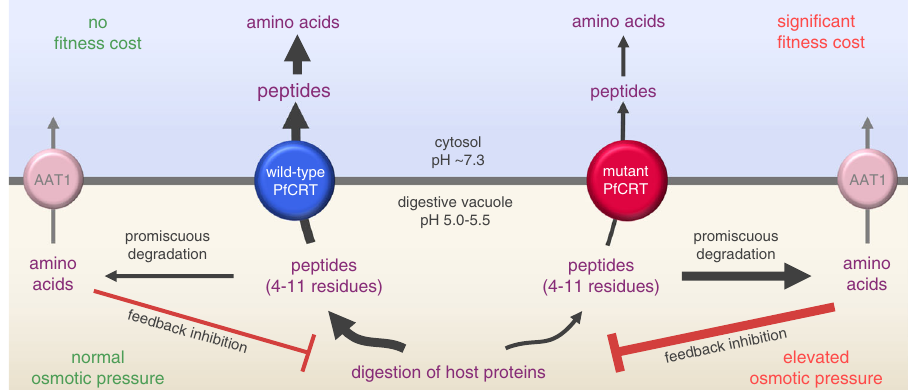
Fig. 8 Model for the natural function and physiological role of PfCRT. PfCRT transports host-derived peptides 4 – 11 residues in length, and of varying composition and charge, out of the DV and into the parasite ’ s cytosol. Wild-type PfCRT transports a broader range of peptides, and has a higher capacity for peptide transport, than most CQ-resistance-conferring isoforms of PfCRT. The diminished abilities of the mutant transporters to ef fl ux peptides results in the accumulation of these peptides within CQ-resistant parasites. Moreover, the promiscuous degradation of the accumulated peptides leads to the build-up of small peptide fragments and amino acids, which exerts further osmotic pressure upon the DV and causes feedback inhibition of the digestion of host proteins. PfCRT therefore serves two roles: (1) it prevents osmotic stress of the DV by exporting peptides and (2) it delivers these peptides to the cytosol where they are degraded into amino acids to fuel parasite growth. AAT1: amino acid transporter estimates of the volume of stage V – VI oocytes (~400 nL 60 ). A subset of The ability of an unlabelled test solute to trans -stimulate [ 3 H]CQ transport via PfCRT (Figs. 2, 5d; Supplementary Fig. 1 and Supplementary Data 1, 2) experiments measured the pH-dependence of the trans -stimulatory effect of was measured using oocytes two days post-cRNA-injection 21 . The oocytes VF-6 on [ 3 H]CQ uptake via PfCRT. The oocytes were injected with VF-6 were injected with 25 nL of an unlabelled solute (to achieve estimated suspended in 25 nL ND96 buffer adjusted to pH 5.0, 5.5, 6.0 or 7.0, which intracellular concentrations of 5 – 45 mM) or a control treatment (ND96 buffer corresponded to the injection of 2.5 – 250 fmol of H + . The Na + -dependence of pH 5.5 or the dipeptide LH; the estimated intracellular concentration of LH was the trans -stimulatory effect of VF-6 was assessed by injecting the oocytes with 45 mM). The intracellular concentrations were calculated using previous VF-6 suspended in ND96 buffer (pH 5.5) or a Na + -free version of this buffer